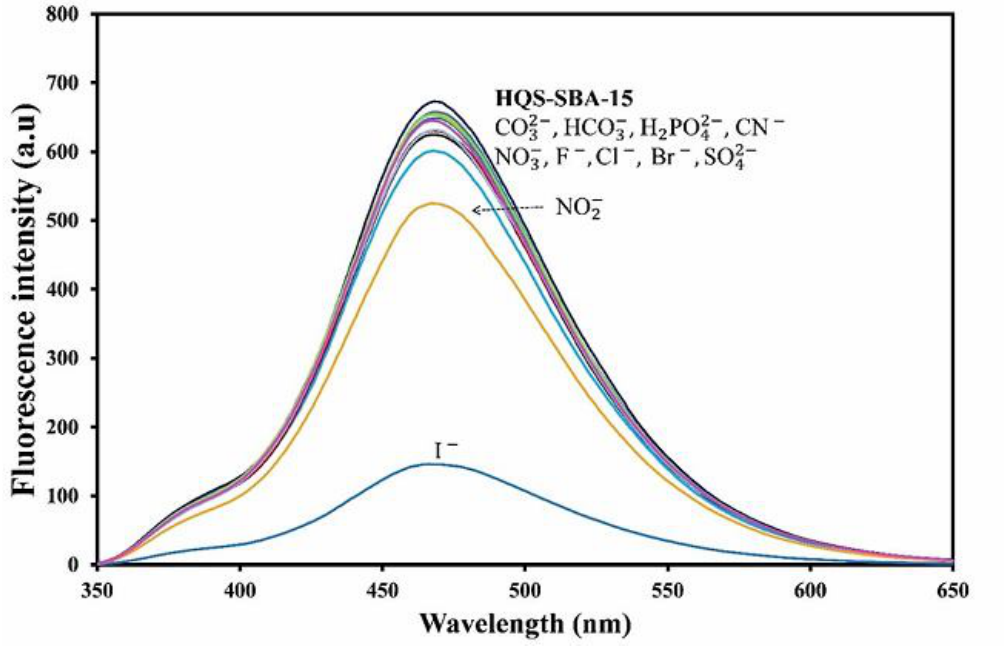
Fig. 10. Fluorescence spectra of the aqueous suspended HQS-SBA-15 in the presence of different anions [35].